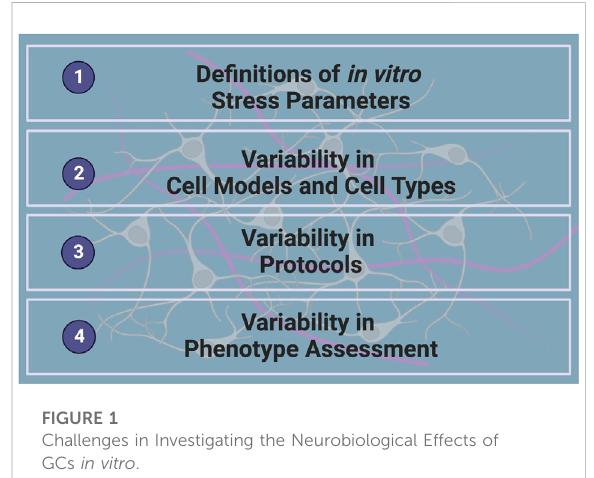
FIGURE 1 Challenges in Investigating the Neurobiological Effects of GCs in vitro